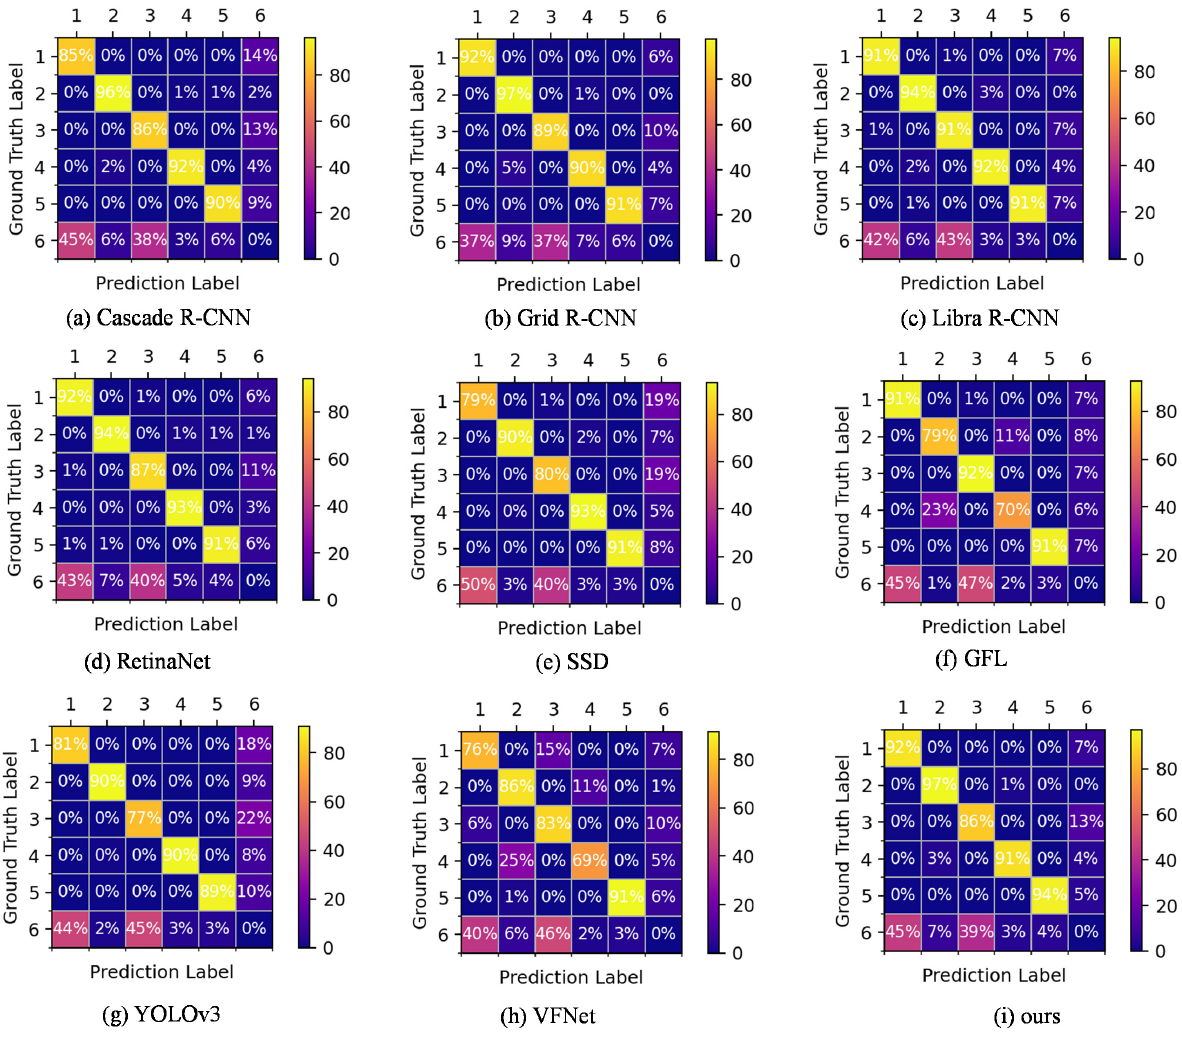
Figure 8. Confusion matrices of different models, where 1–6 in the confusion matrix represents frogeye leaf spot, powdery mildew, rust, scab, mosaic and background. frogeye leaf spot, powdery mildew, rust, scab, mosaic and